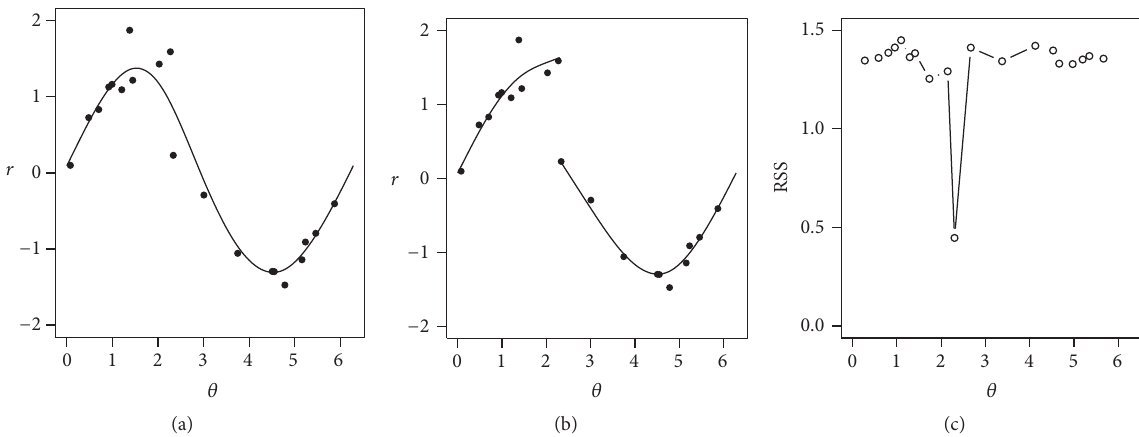
Figure 3: (a) Data from sin function with a discontinuity; (b) best two-part curve; (c) residual sum of square for two-part curves.